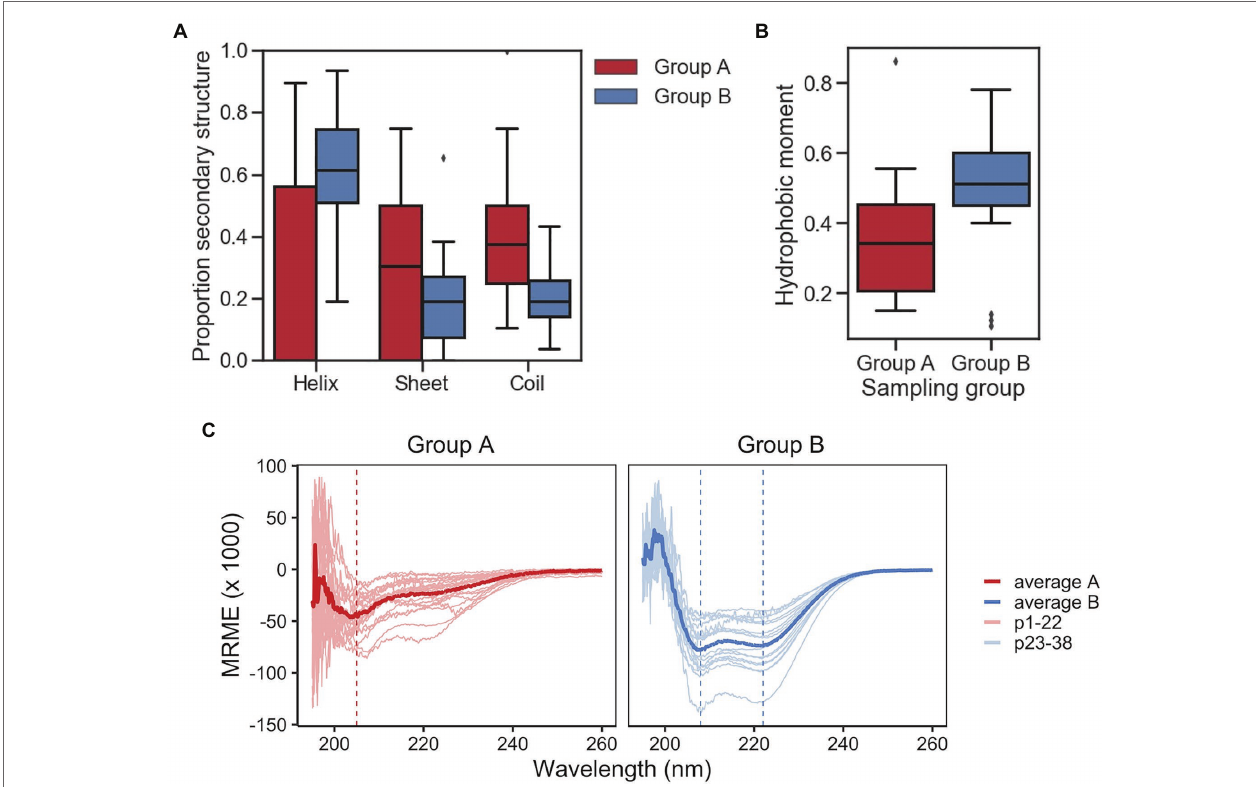
FIGURE 3 | Generated peptide characterization. (A) Boxplot of the predicted helix, sheet, and coil percentages calculated from Group A and Group B sampling groups into the GOR IV algorithm. Group A and Group B are significantly different ( p < 0.01, Welch’s two-sided t -test) for helix, sheet, and coil. (B) Boxplot of the calculated hydrophobic moments obtained by applying the modlAMP function calculate_moment on the sequences from Group A and Group B sampling groups. The differences between Group A and Group B groups are significant ( p < 0.01, Welch’s two-sided t -test). (C) Mean residue molar ellipticity (MRME) plots of peptides from group A (left) and group B (right) in the presence of membrane mimic 60 mM sodium dodecyl sulfate (SDS). Each scan was averaged from three scans for each peptide with peptide-free buffer baseline scan subtracted. Lighter colored lines are individual peptide scans; darker colored lines are average scan for the group. Vertical lines highlight approximate minima of average scans: 205 nm for Group A; 208 and 222 nm for Group